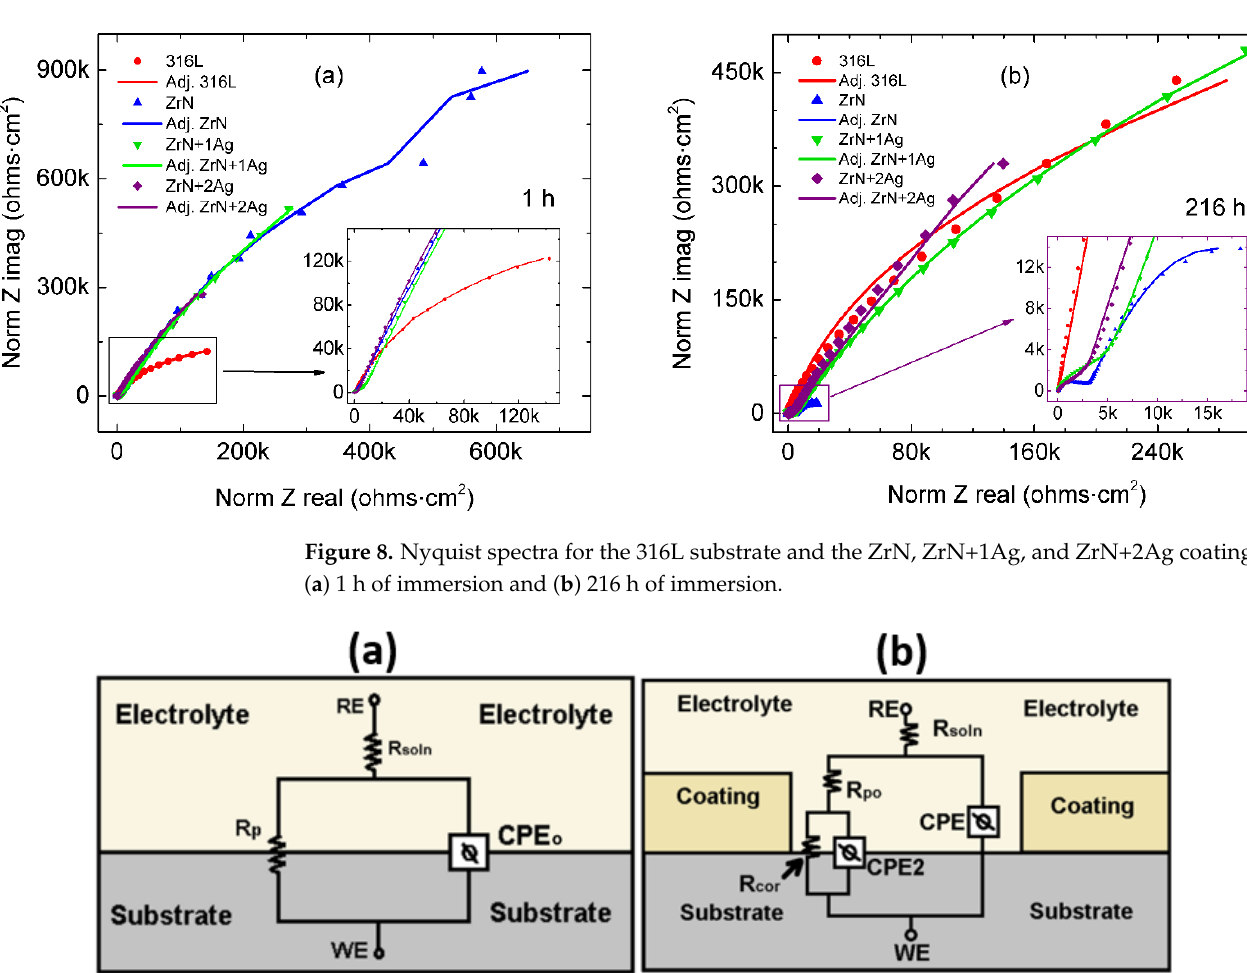
Figure 9. Equivalent circuit model used for fitting the EIS experimental data for ( a ) AISI 316L and ( b ) ZrN, ZrN+1Ag, and ZrN+2Ag coatings. Table 5. EIS fitting parameter of AISI 316L after 1 h and 216 h of immersion in a Ringer’s solution at 37.5 °C.